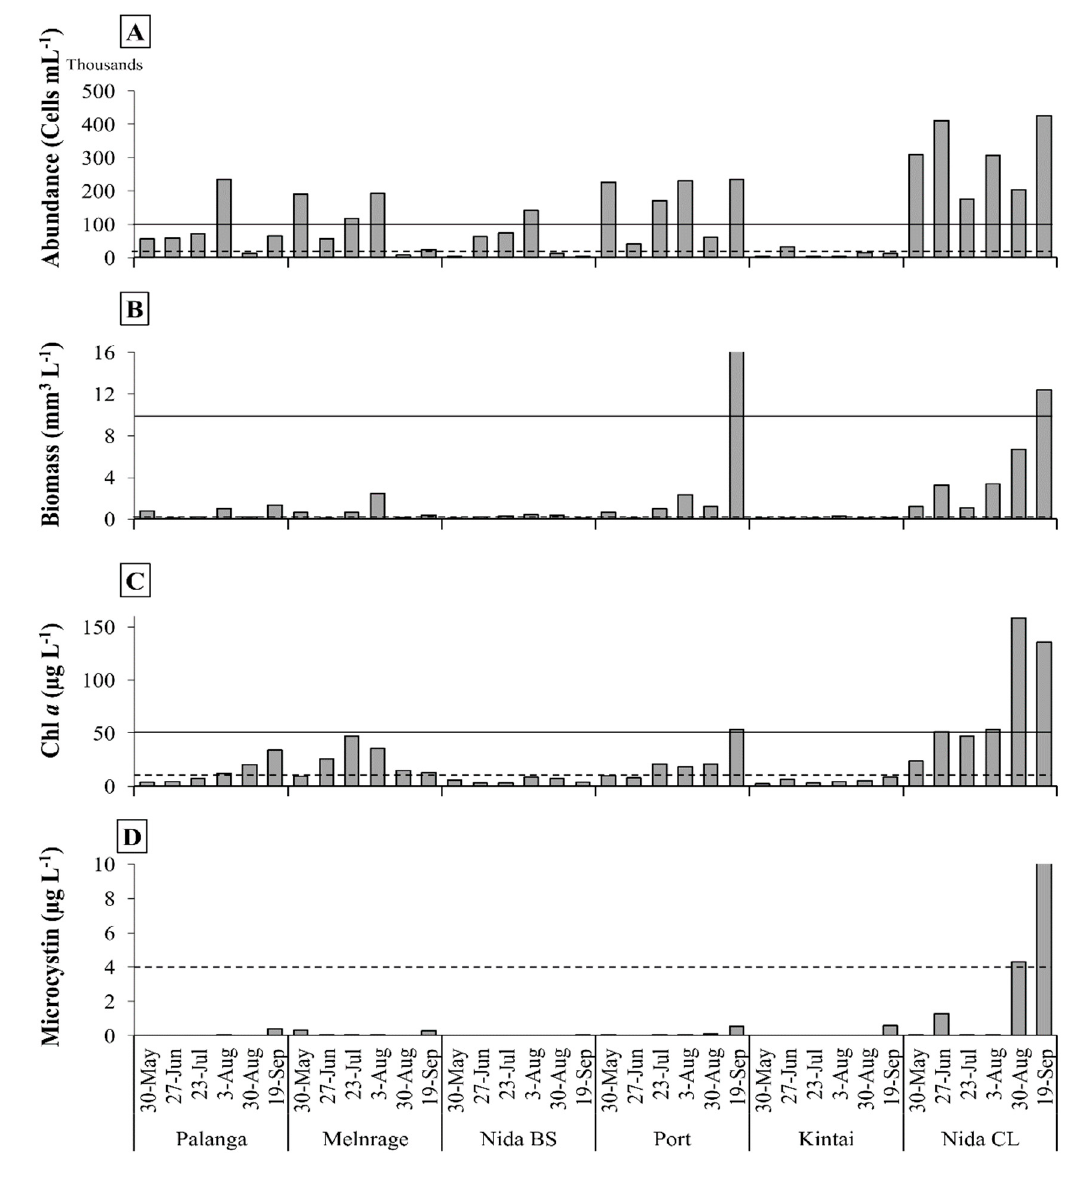
Figure 3. Cyanobacterial abundance (cells mL − 1 ) ( A ) cyanobacterial biomass (mm 3 L − 1 ); ( B ) chlorophyll (Chl) a ( µ g L − 1 ); ( C ) and microcystin (MC) concentration ( µ g L − 1 ); ( D ) obtained in May–September 2018 along the coast of Lithuania and the Curonian Lagoon. Black horizontal lines represent ‘high’ risk alert level, while the dotted lines indicate ‘low’ risk level thresholds.